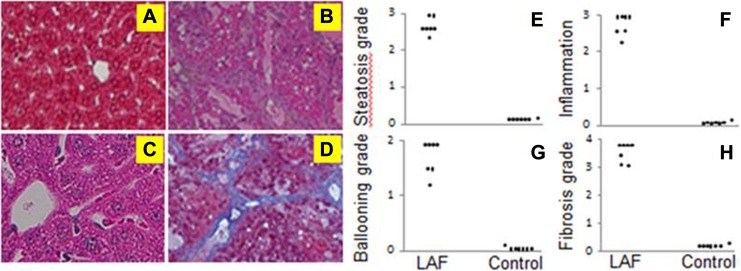
Hepatic histopathology. Hematoxylin and eosin stained liver sections in control mice (n = 7) (A) and ethanol-fed (B) mice (n = 7). Masson trichrome stain for fibrosis in control mice (C) and ethanol-fed mice (D). Magnification is 100×. There is significant increase in steatosis (E), liver inflammation (F), ballooning (G), and fibrosis (H) in ethanol-fed mice compared to controls.